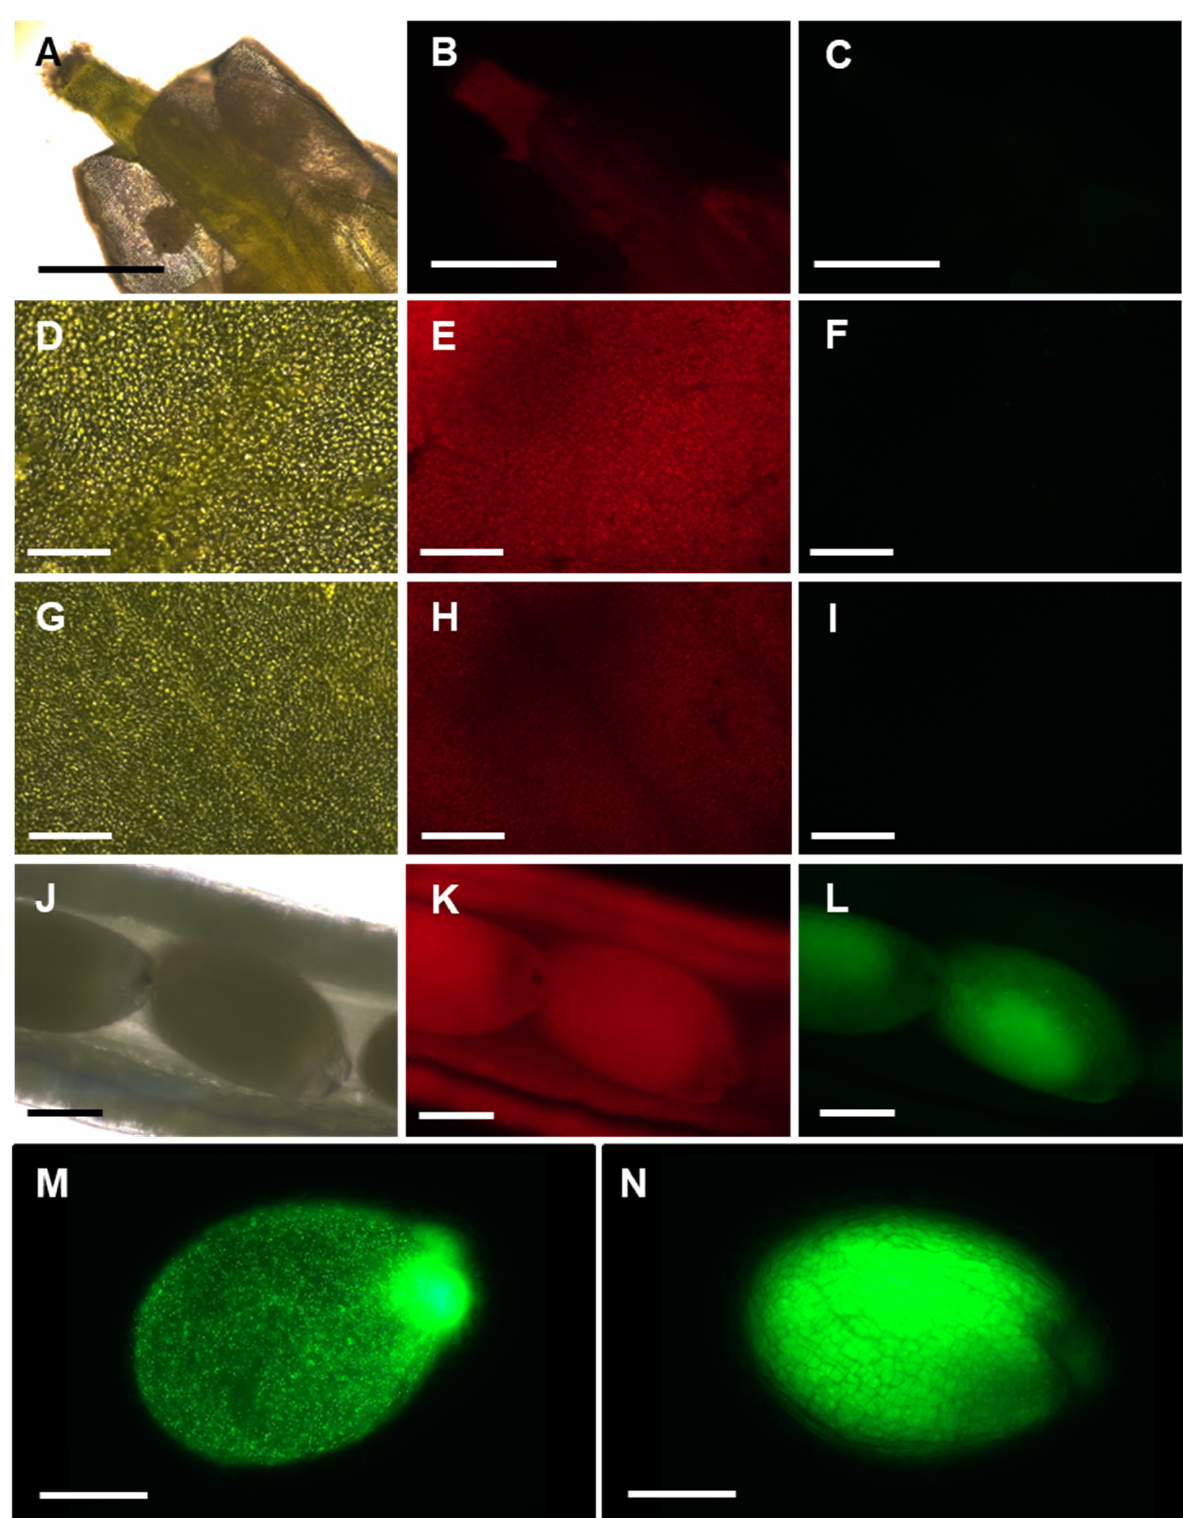
Figure 7. APx-R-YFP accumulation in vegetative and reproductive tissues. Fluorescence microscopy images of a representative AtAPx-R-YFP OE-2: flower ( A – C ); rosette leaf ( D – F ); cauline leaf ( G – I ); immature seeds ( J – M ); and mature seed ( N ). Bright field ( A , D , G , J ); chlorophyll autofluorescence ( B , E , H , K ); and YFP fluorescence ( C , F , I , L – N ). Scale: ( A – C ) 1 mm; ( D – I ) 100 µm; and ( J – N ) 400 µm.